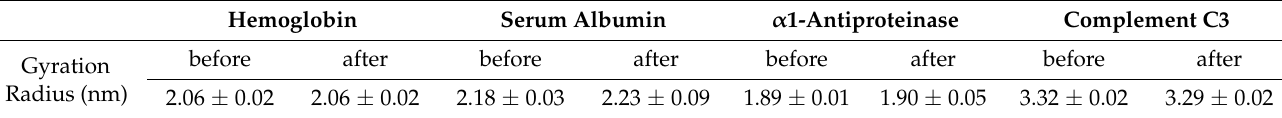
Table 2. Gyration radius in nm for the four proteins before (i.e., the free protein) and after binding with the all-MUS AuNP. Hemoglobin Serum Albumin α 1-Antiproteinase Complement C3 before Gyration Radius (nm) before after